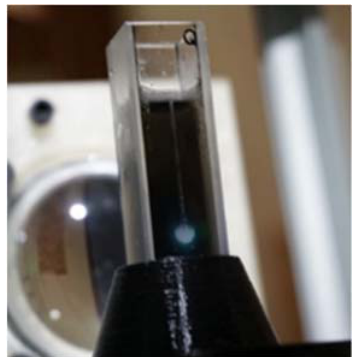
Figure 19. Production of vapor bubbles in NH1 samples under irradiation at 355 nm. The contrail of vapor rising up to the nanofluid surface is clearly visible above the white spot.